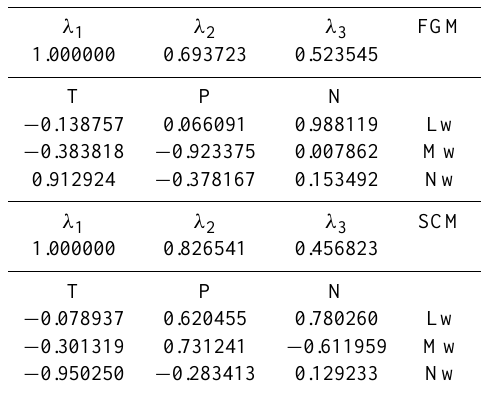
Table 2. Top: directions of the axis of variance obtained from MVA applied to Thd flux-gate data filtered between 0.8 and 2Hz (the maximum frequency covered during this event). Bottom: same for search-coil data filtered between 0.8 and 4Hz. Results are given in TPN coordinates (see Fig. 4 and text). Lw, Mw and Nw are the LMN components of the waves.